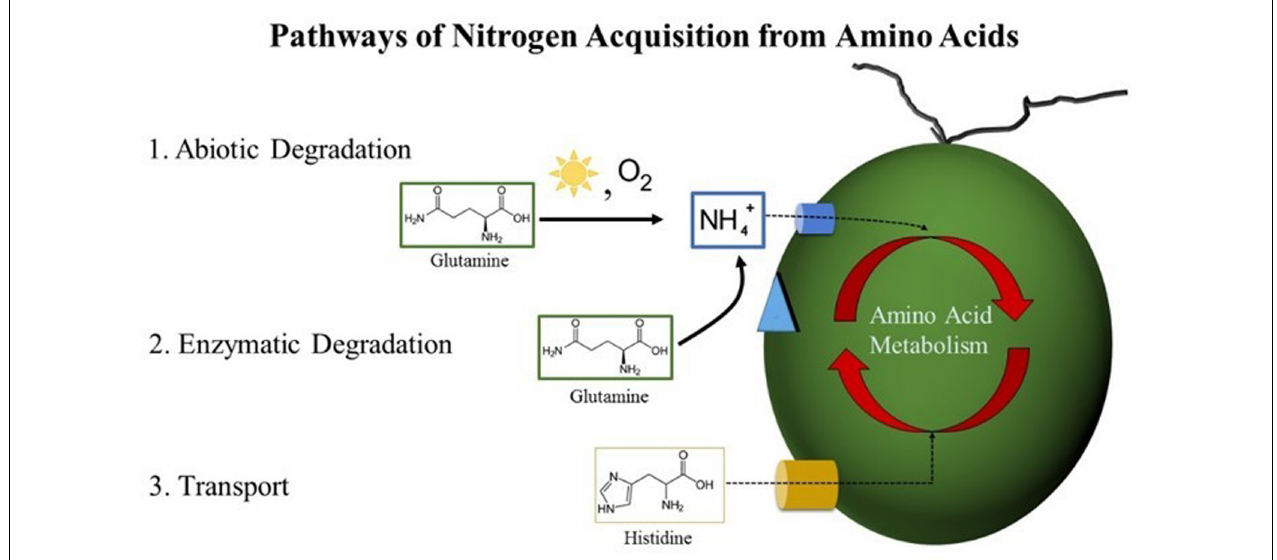
FIGURE 8 | Pathways of nitrogen acquisition from amino acids by Dunaliella spp. Postulated routes by which nitrogen from amino acids could be acquired by Dunaliella spp. from the growth medium. (1) Abiotic degradation resulting in the production of NH 4 + can occur via nucleophilic attack of primary amines by atmospheric oxygen catalyzed by the presence of heat and light. Released NH 4 + can cross the cell membrane via a transport protein into the cell where it is assimilated via the GS-GOGAT pathway. (2) Enzymatic degradation of amino acids could occur if a Dunaliella species possesses an enzyme similar to the LAO1 protein of C. reinhardtii or another similar protein. This pathway would in effect release NH 4 + , which would be assimilated as in pathway 1. (3) Transport of amino acids across the cell membrane is mediated by a transporter. Once inside the cell, amino acids can be enzymatically degraded either by conversion into other amino acids via transamination or by the release and subsequent assimilation of NH 4 +